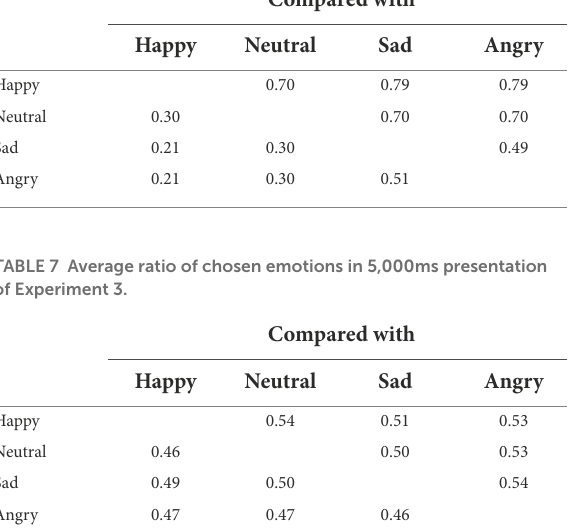
comparisons based on a 95% confidence interval demonstrated TABLE 6 Average ratio of chosen emotions in 500 ms presentation of Experiment 3.